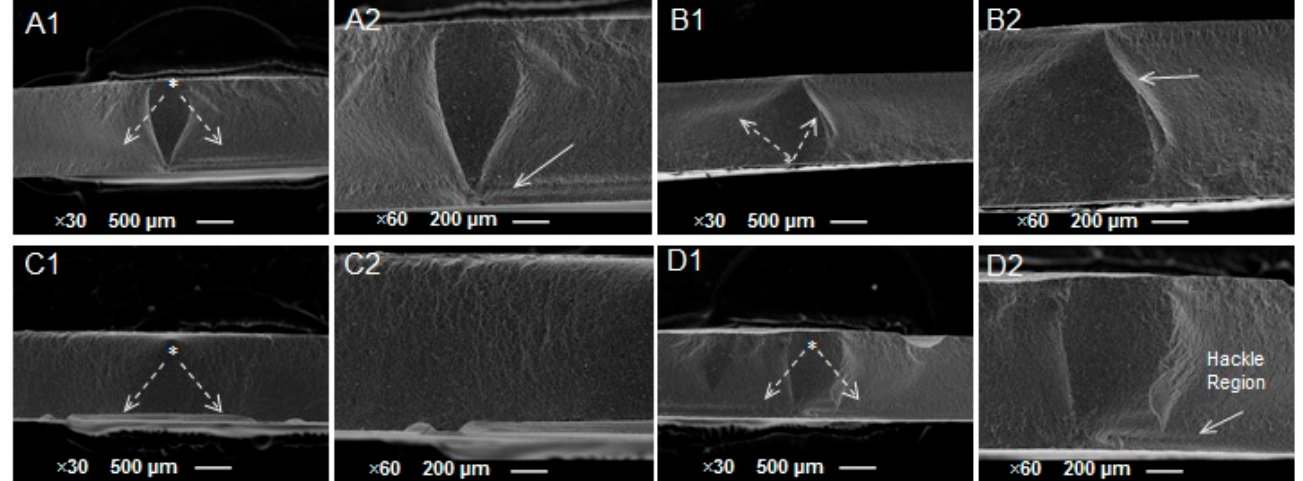
Figure 5. SEM images of fractured surface of representative VE specimen following BFS test: ( A1 ) control specimen shows the origin (asterisk) and extent of the crack (dotted white line). Multiple crack planes and voids are also shown; ( A2 ) higher magnification shows compression curl (solid white line). ( B1 ) MP specimen shows the origin and extent of the crack; ( B2 ) higher magnification showing crack arrest line (solid white line); ( C1 ) OG specimen shows the origin and extent of the crack; ( C2 ) river lines are shown which indicates cracks propagating on different planes; ( D1 ) MP+PP specimen shows the origin and extent of the crack; ( D2 ) compression curl and hackle region are shown.